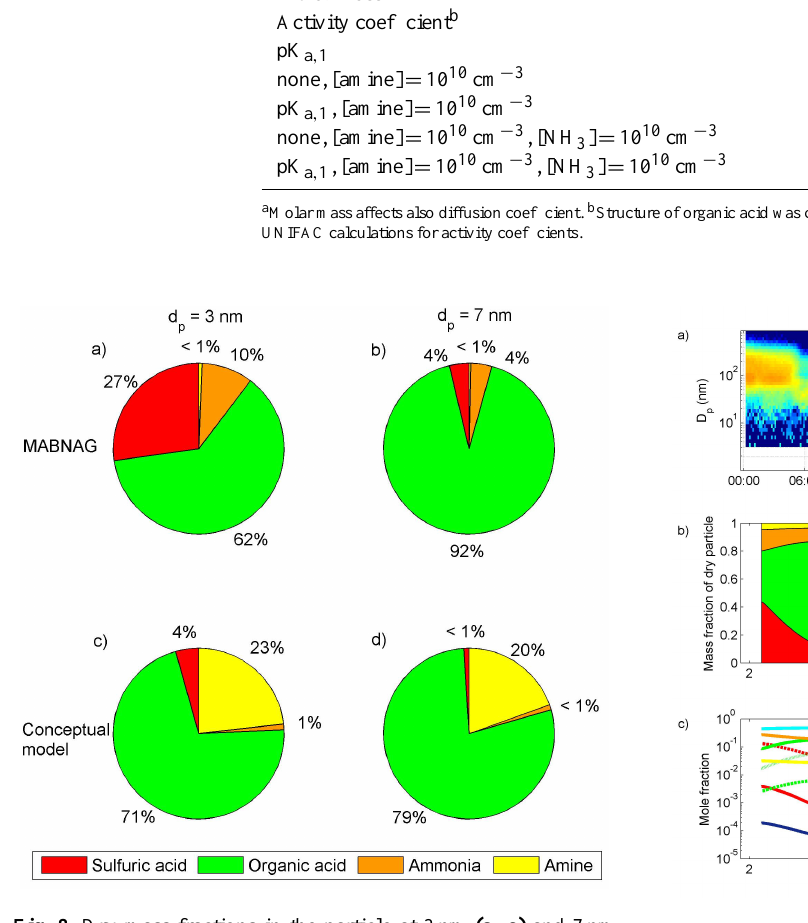
Fig. 8. Dry mass fractions in the particle at 3nm (a, c) and 7nm (b, d) predicted with MABNAG (a, b) and the conceptual growth model ( c, d ; Riipinen et al. 2012). Gas phase concentration of sulfuric acid, organic acid, ammonia and amine were 10 6 cm − 3 , 3 × 10 8 cm − 3 , 10 10 cm − 3 and 10 8 cm − 3 , respectively, and RH was 40%. Saturation vapour pressure of organic acid was set to 10 − 6 Pa and other properties of organic acid were as for organic acid 1 (Ta- ble 1).